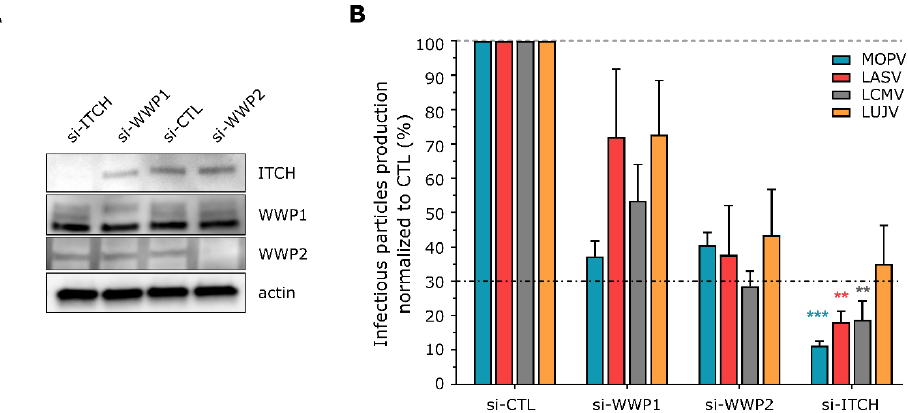
Figure 1. (Color online) Fidelity for the constant magnetic field ( N = 8 ) : ( a ) The evolution of fidelity at Figure 1. siRNA screen of ITCH, WWP1 and WWP2 during old-world arenavirus infection. ( A ) A549 different magnetic field strength B for λ = 1. ( b ) The minimum value of fidelity F min plotted versus cells were transfected with siRNA against ITCH (si-ITCH), WWP1 (si-WWP1), WWP2 (si-WWP2) or the magnetic field strength B and anisotropy parameter λ . ( c , d ) are sections of ( b ) in the λ and B axes, with a non-targeting siRNA (si-CTL) for 72 h before analysis of silencing e ffi ciency by western blotting respectively. ( n = 4 independent experiments). ( B ) A549 cells were transfected with the indicated siRNA for 72 h before infection with the indicated virus at a MOI of 0.01. Two days after infection, cell supernatants were harvested and titrated on Vero cells. The viral titer was calculated as FFU / mL before normalization to control the conditions. The dotted line corresponds to the threshold at which a mean drop of 70% of infectious particles production was observed. The results show the mean percentages ± SEM pooled from four independent experiments. ** p < 0.01, and *** p < 0.001 as determined by a Kruskal–Wallis test followed by Dunn’s post hoc test for multiple